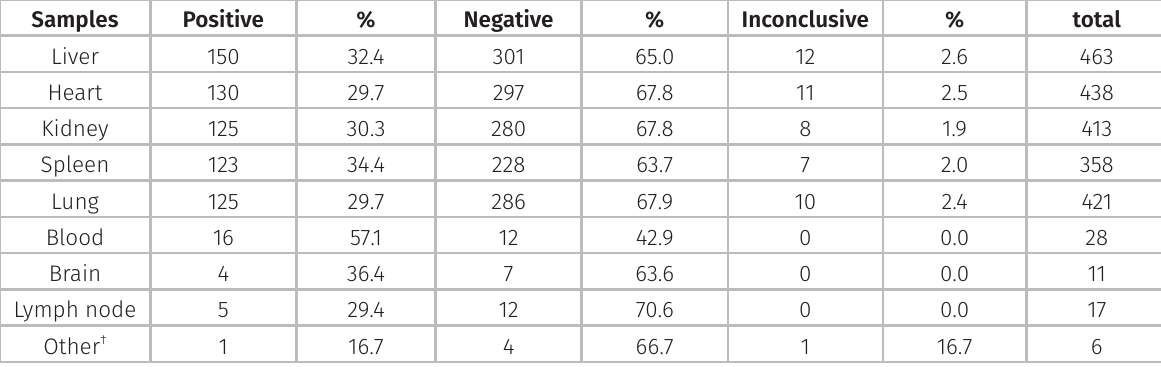
Table I. Frequency of collection of organ fragments from non-human primates tested for yellow fever.